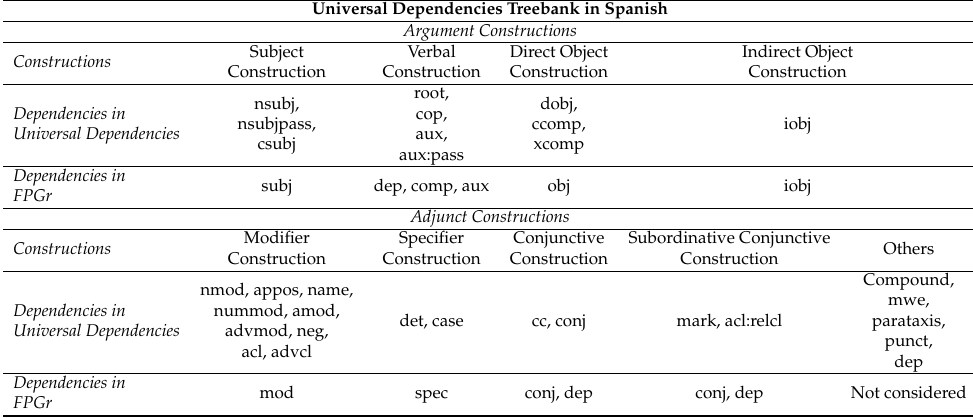
Table 2. Contrasting constructions, Universal Dependencies dependencies, and FPGr